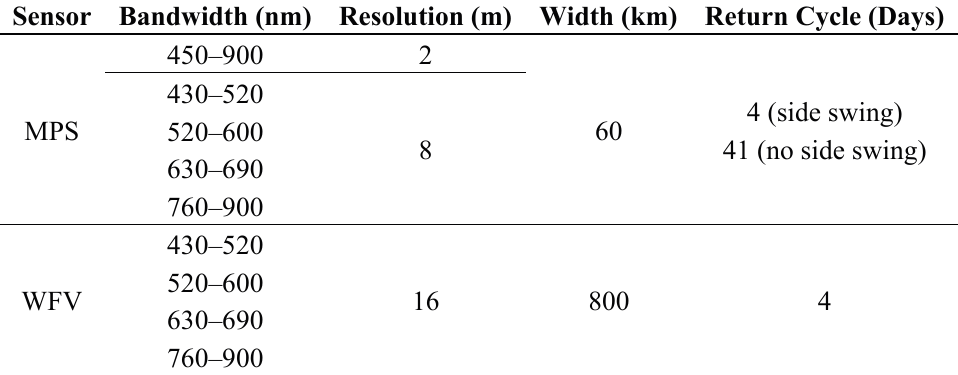
Table 3. Parameters for the GF-1 satellite